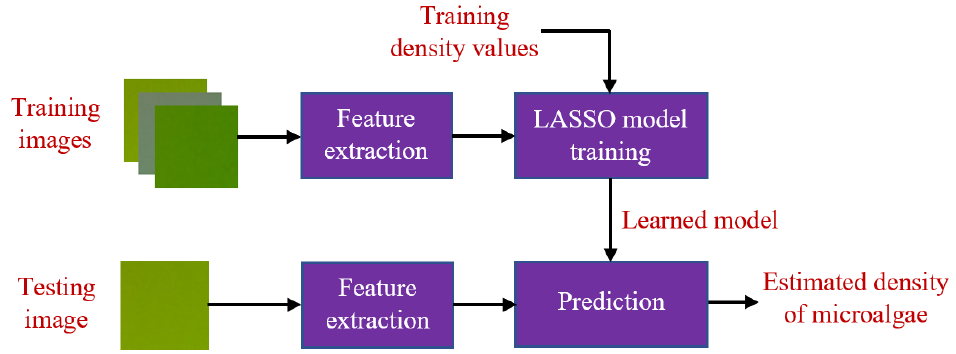
Figure 9. Framework of the validation